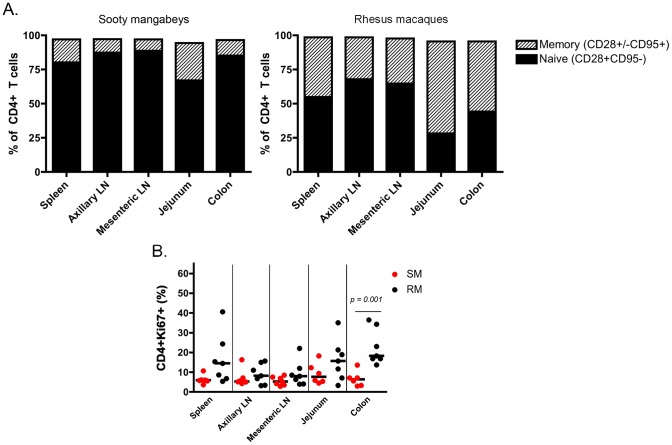
T cell differentiation and proliferation in infant SM and RM tissues.(A) The proportion of naïve (CD28+CD95−) and memory (CD28+/−CD95+) CD4+ T cells in lymphoid and gastrointestinal tissues of infant SMs and RMs was measured at necropsy. For each tissue site, the total may not add to 100% because of minor populations excluded in gating. (B) The level of cell activation/proliferation was measured in CD4+ T cells isolated from multiple tissues of infant RMs and SMs using the marker Ki-67. Mann-Whitney test was used to determine significance. Comparisons without p value shown were non-significant.